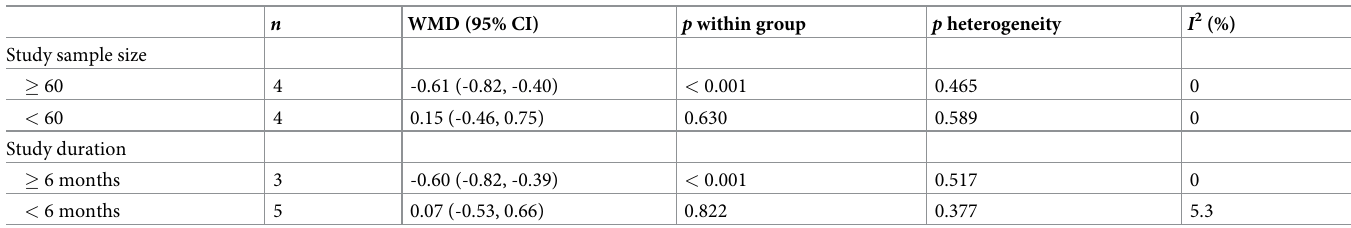
Table 2. Subgroup analyses of tocotrienols on C-reactive protein